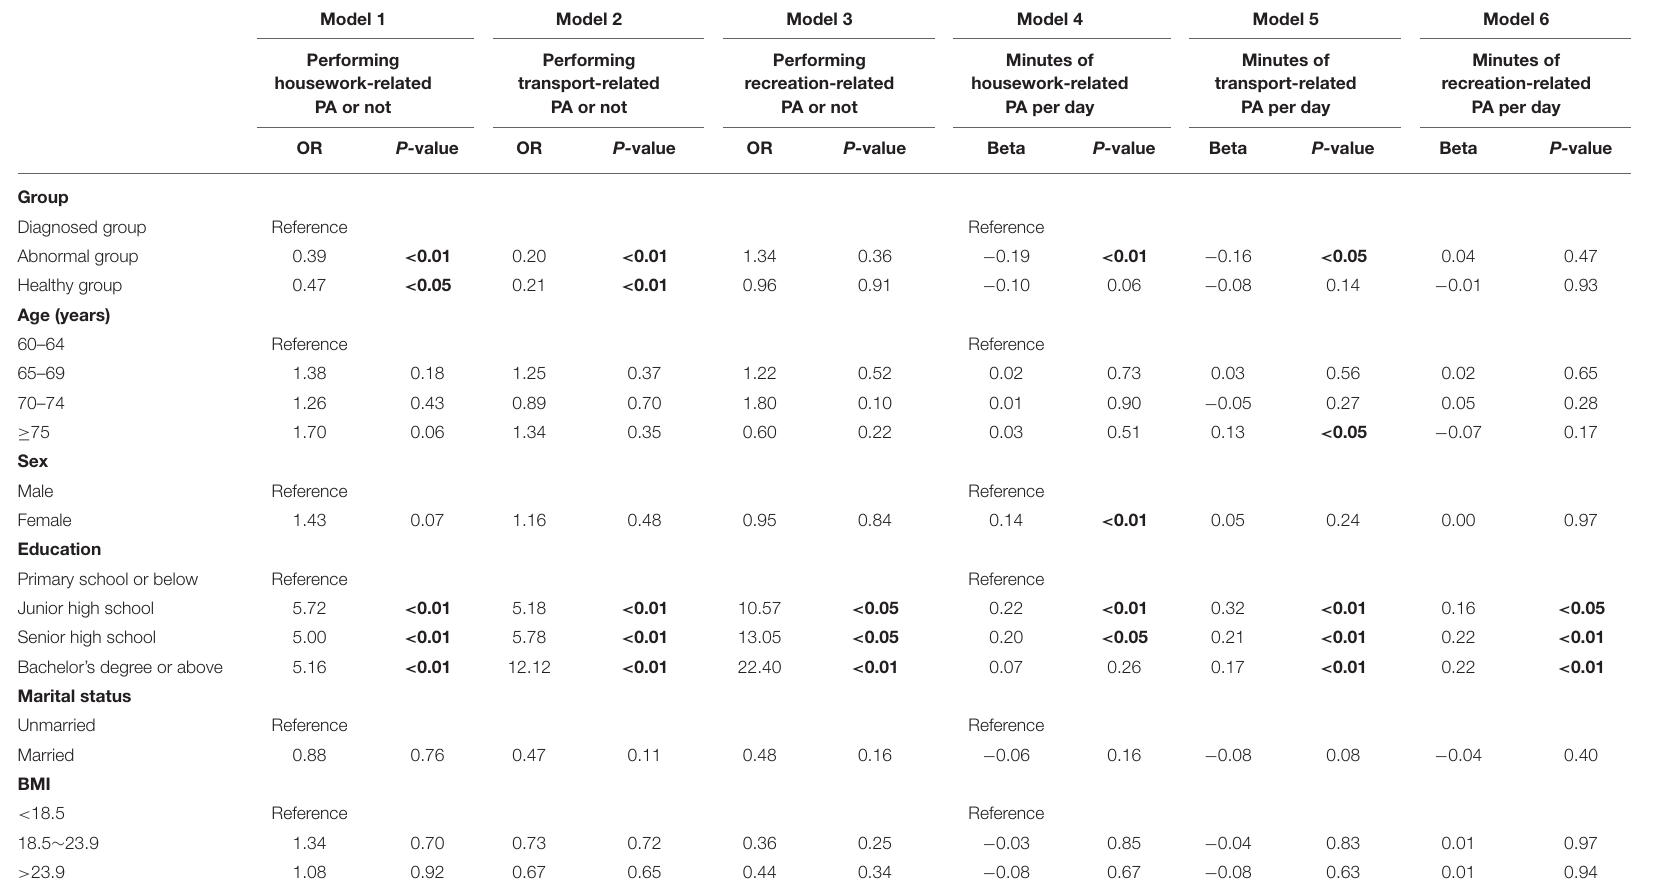
Bold numbers indicate that the differences were statistically